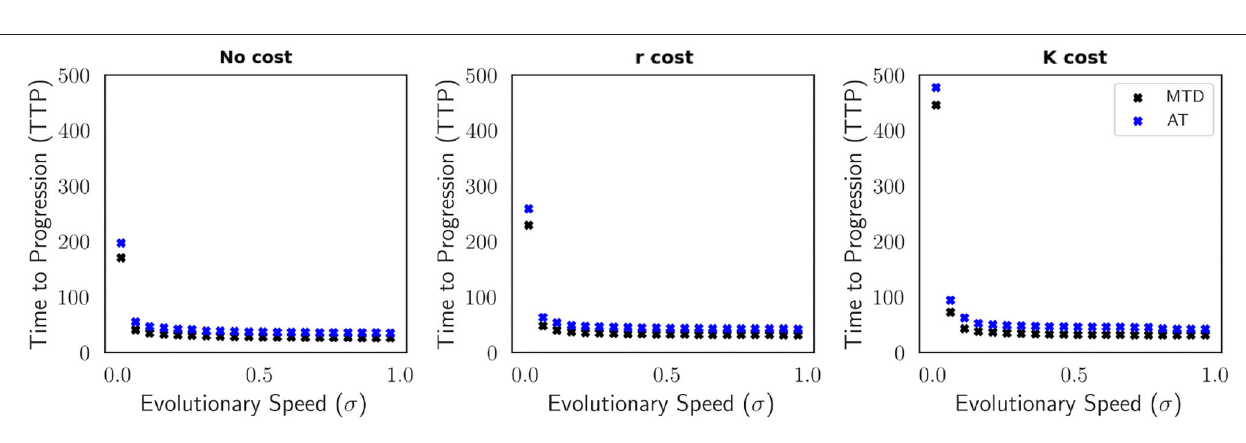
burden drops 20% of initial density ( Figure 5B ). This change in protocol amplifies the results shown when using a 50%